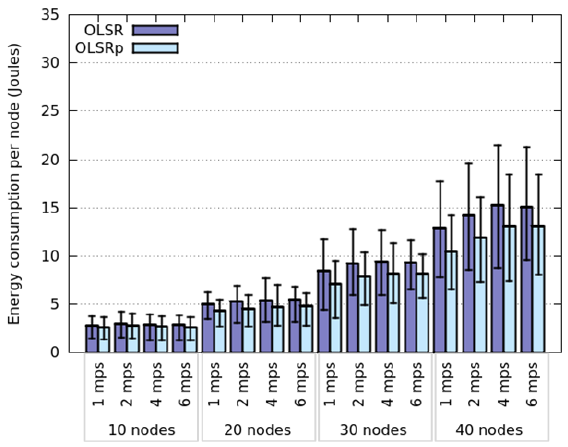
Figure 8. Energy consumption when nodes follow a Nomadic model.